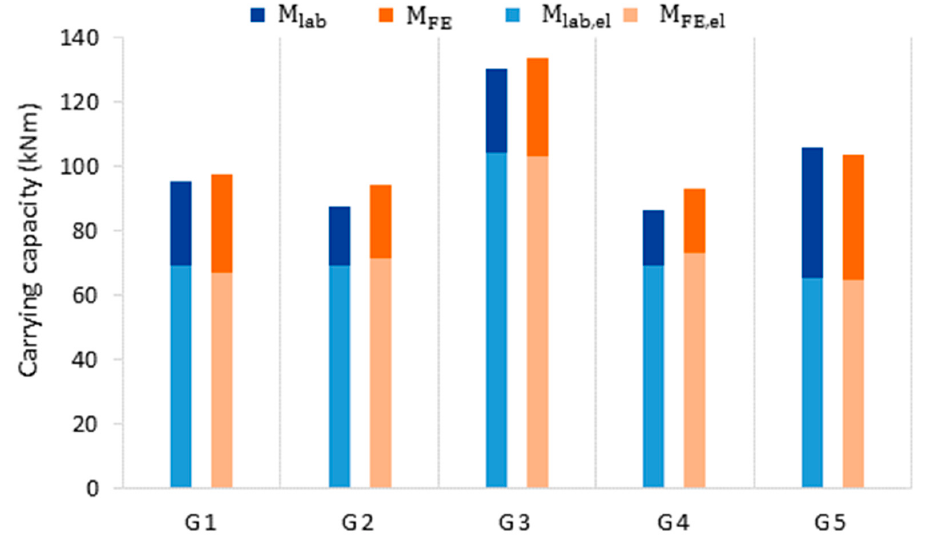
Figure 11. Elastic and ultimate moment capacity obtained from laboratory test ( blue ) and numerical simulations ( orange ).